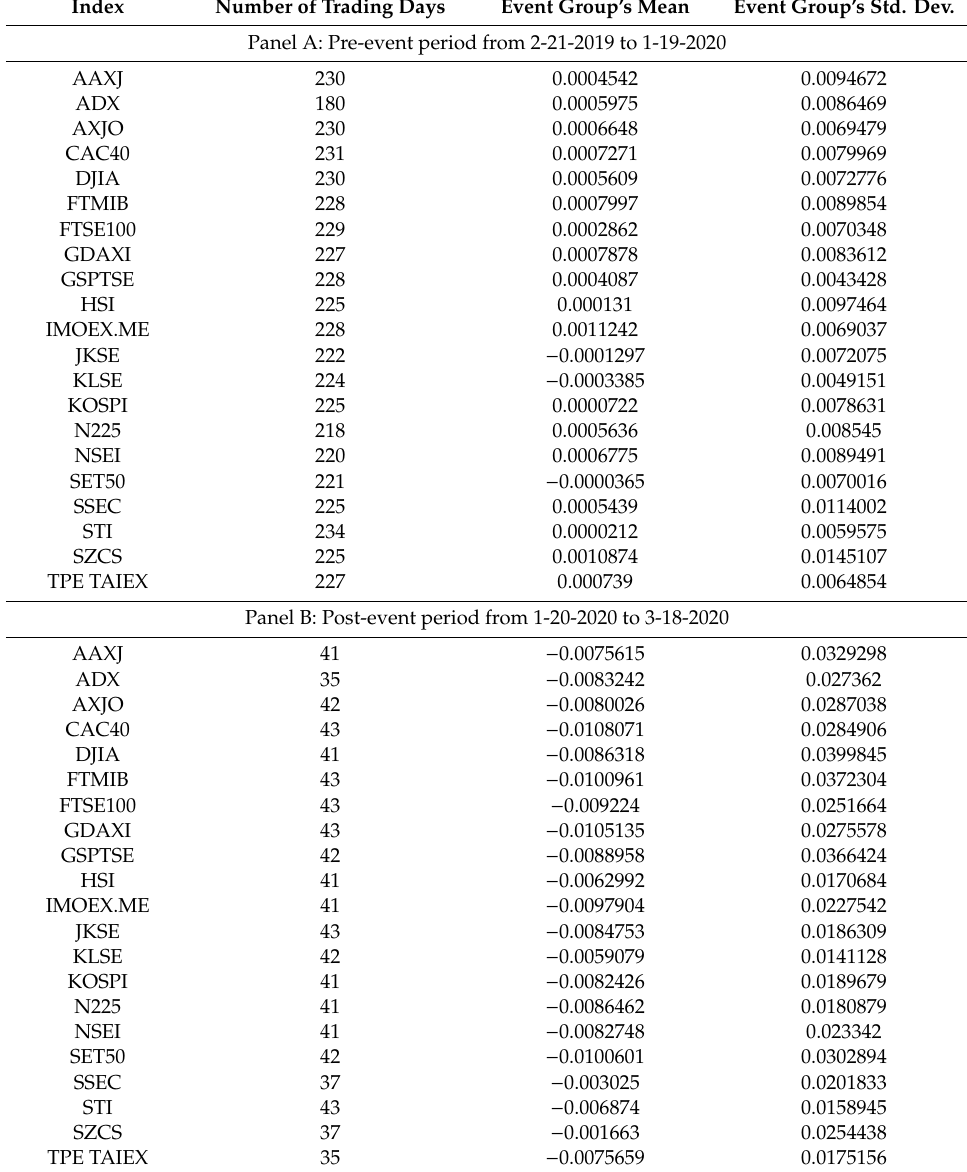
Table 3. Di ff erences in mean returns of sample